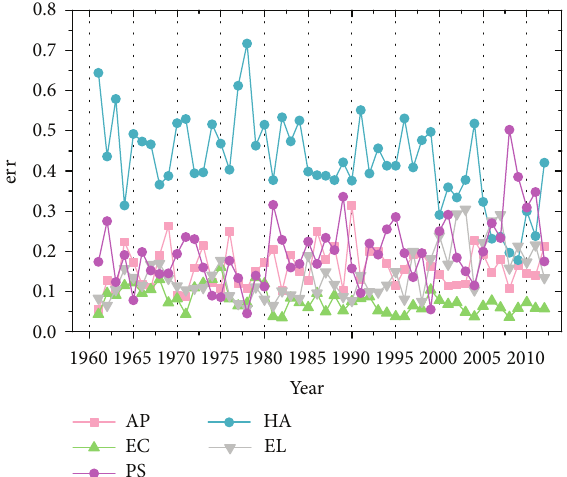
Figure 4: err (𝑋 𝑗 ) values of five representative factors versus time.